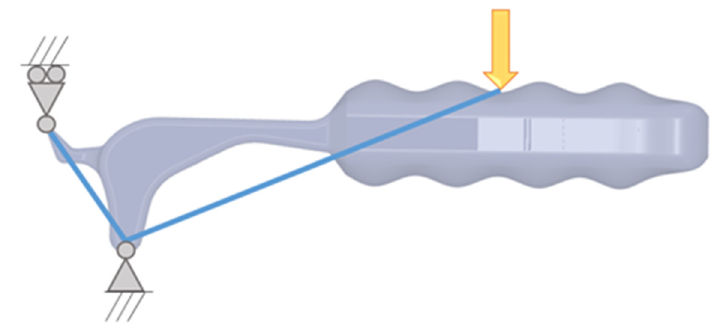
Figure 6. Structural model for shape computation and simulation.